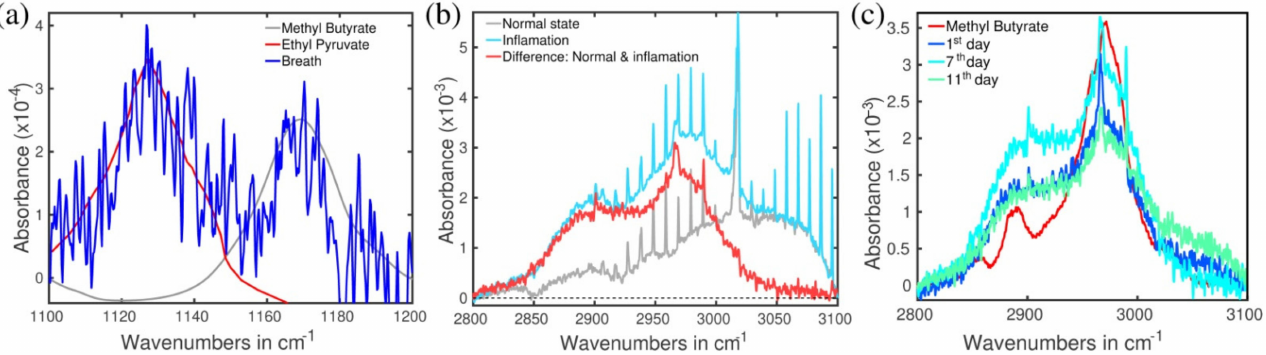
Figure 3. ( a ) Breath absorption spectra at 1130 cm − 1 together with the ethyl pyruvate spectrum (red) taken from [27] as the best fitting candidate, and at 1170 cm − 1 together with the methyl butyrate [27] (grey). The spectra correspond to day “ − 2” (the first elevated points on the left plot of Figure 1). Noisy signals are caused by the presence of residual water. ( b ) The difference (red) between the inflammation (day “0”, turquoise blue) and normal state (day “10 Feburary 2018”, gray). Sharp spikes in the turquoise blue and gray curves belong to methane. ( c ) Differential (see text) breath absorption spectrum taken during the antibiotic treatment together with the measured methyl butyrate absorption spectrum as the best fitting candidate